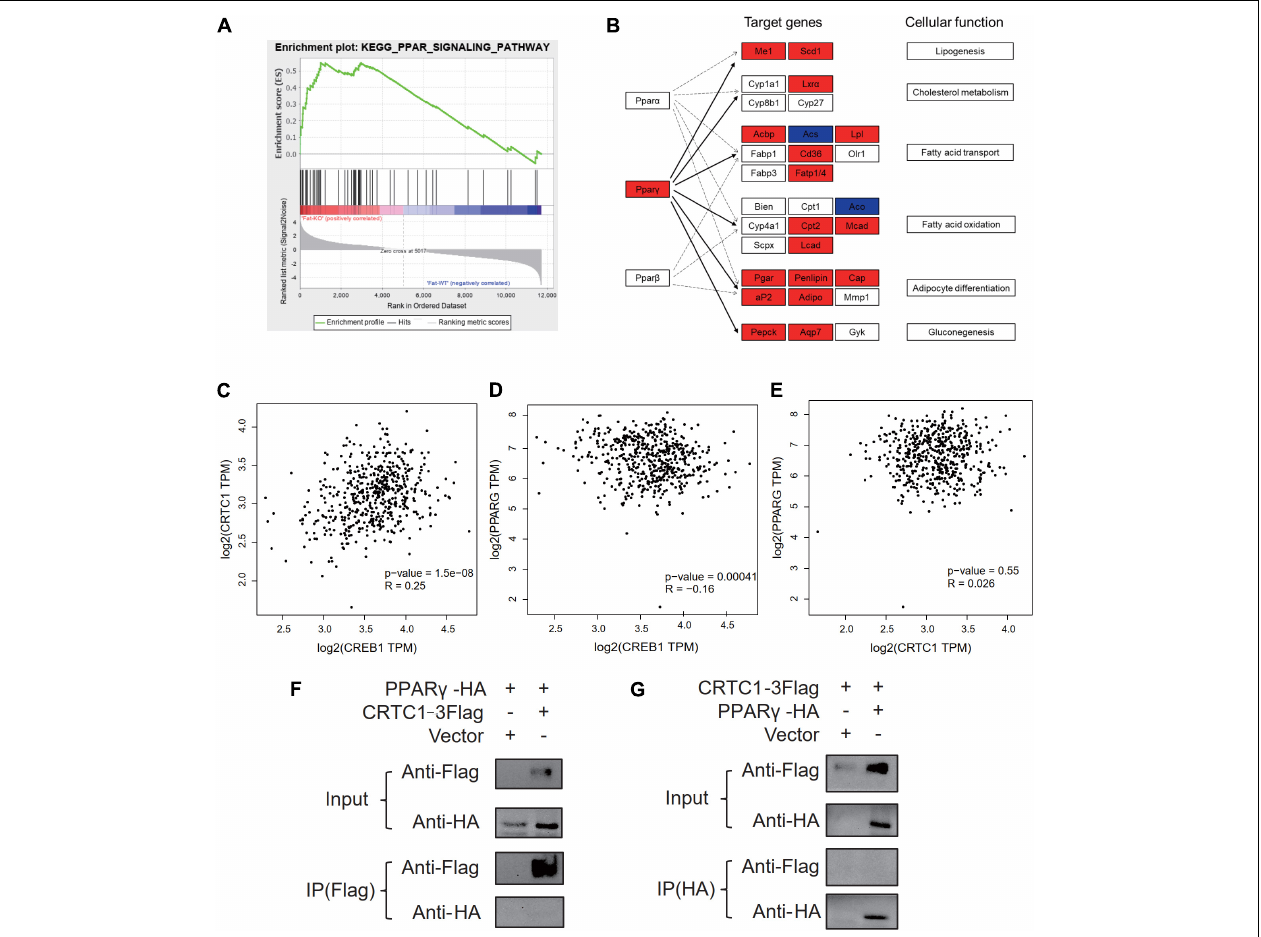
FIGURE 8 | Crtc1 deletion up-regulated the PPAR signaling pathway. (A) PPAR signaling pathway was enriched in GSEA. (B) Enrichment analysis of DEGs in eWAT tissue in PPAR pathway using KEGG map. Red represents upregulated genes. Blue represents downregulated genes. (C–E) Scattered plot of correlation between Crtc1, Creb1 and Ppar γ in human adipose tissue using GEPIA. (F,G) Co-IP validation of protein interactions between CRTC1 and PPAR γ by Flag primary antibody(F) and HA primary antibody (G) , respectively.